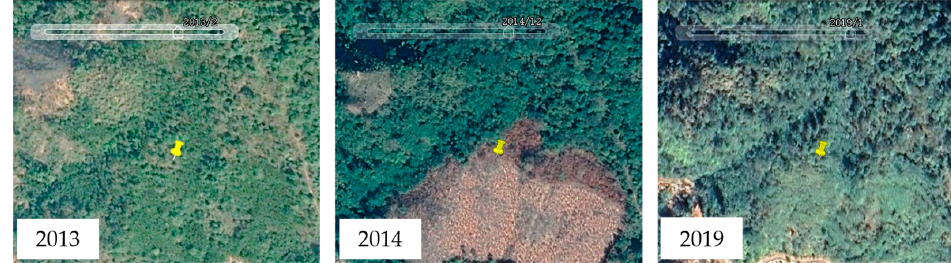
Figure 3. High ‐ resolution satellite imagery from Google Earth Pro at point (93.8182° E, 27.7992° Figure 3. High-resolution satellite imagery from Google Earth Pro at point (93.8182 ◦ E, 27.7992 ◦ N).